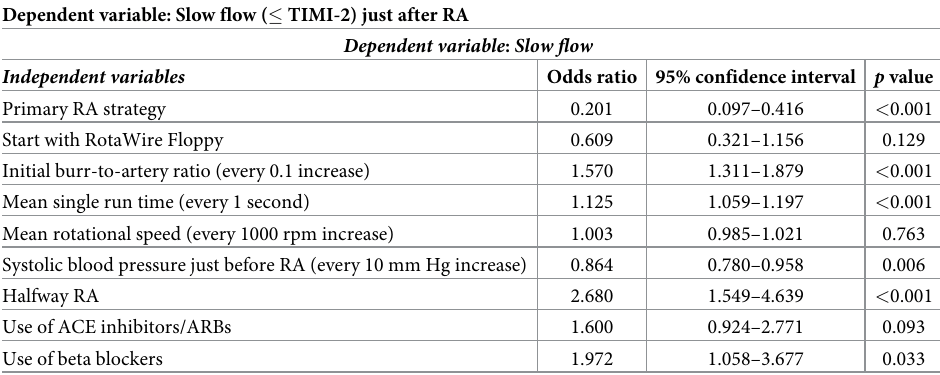
Table 4. Multivariate logistic regression model to find modifiable factors associated with slow flow. Dependent variable: Slow flow ( � TIMI-2) just after RA